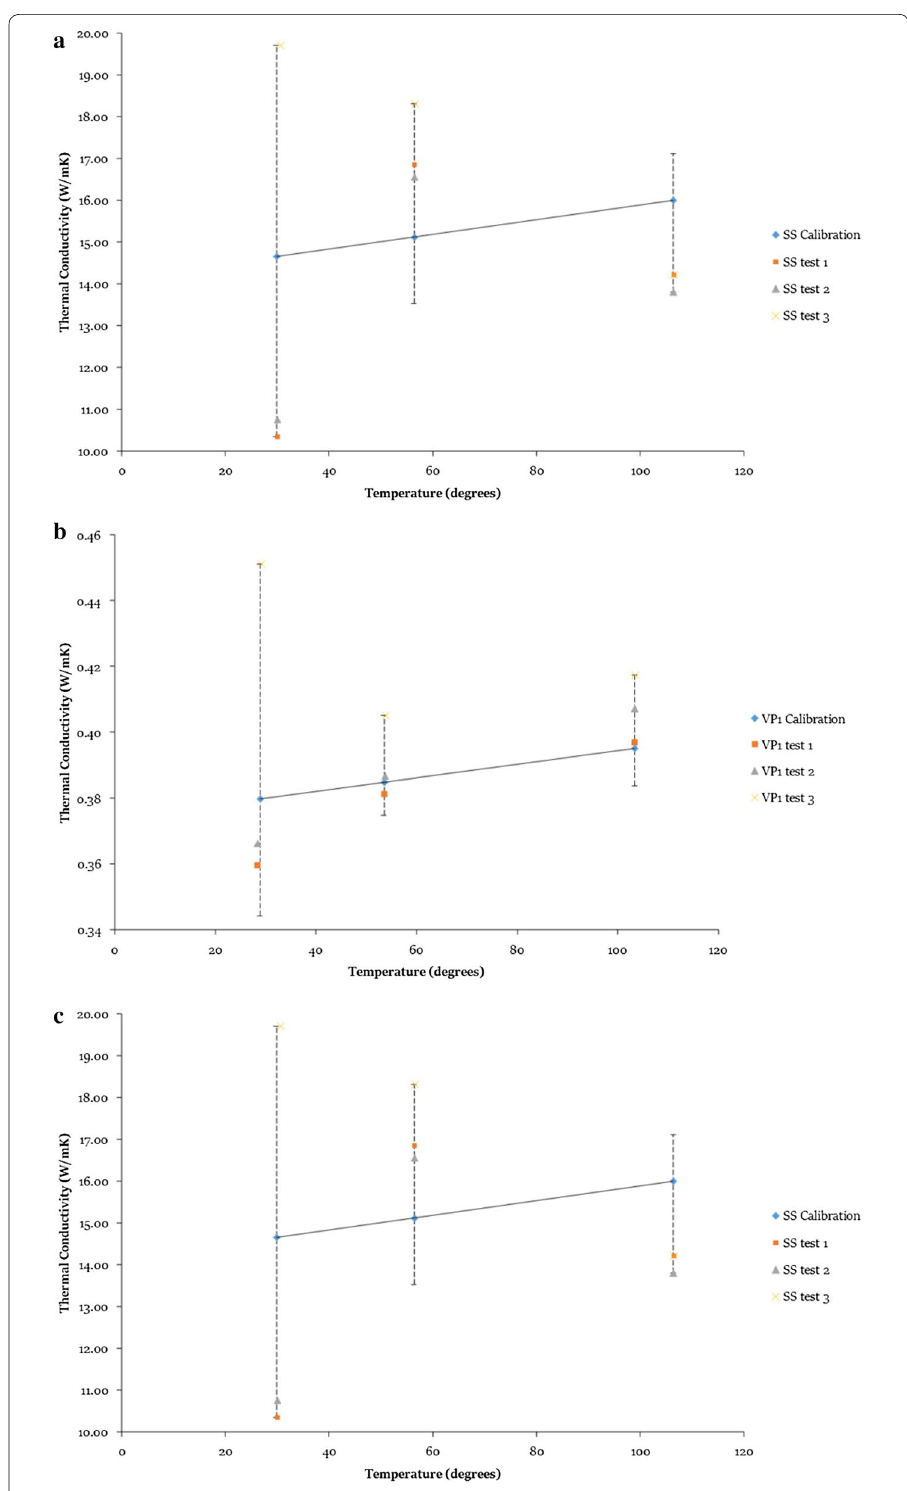
Fig. 2 Calibration thermal conductivity for a —stainless steel sample (19.05 mm) high error margin at 20 °C for stainless steel sample, b —vespel 1 (3.175 mm) high error margin at 20 °C for vespel 1, c —vespel 2 (9.525 mm) high error margin at 20 °C for vespel 2. Error margin persistently decreases at higher